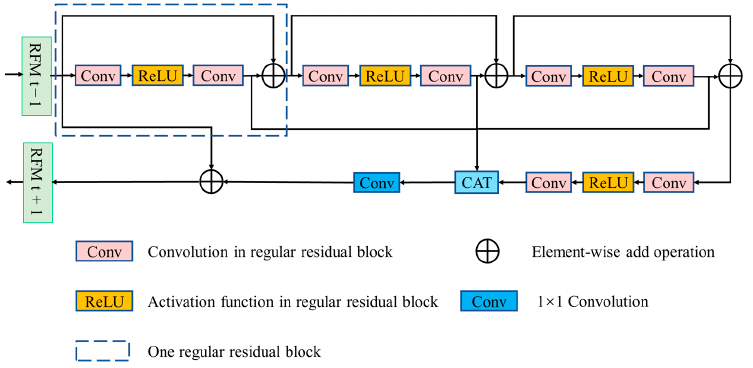
Figure 3. The t -th residual fusion module (RFM) consists of four regular residual blocks and one 1 × 1 convolutional layer.